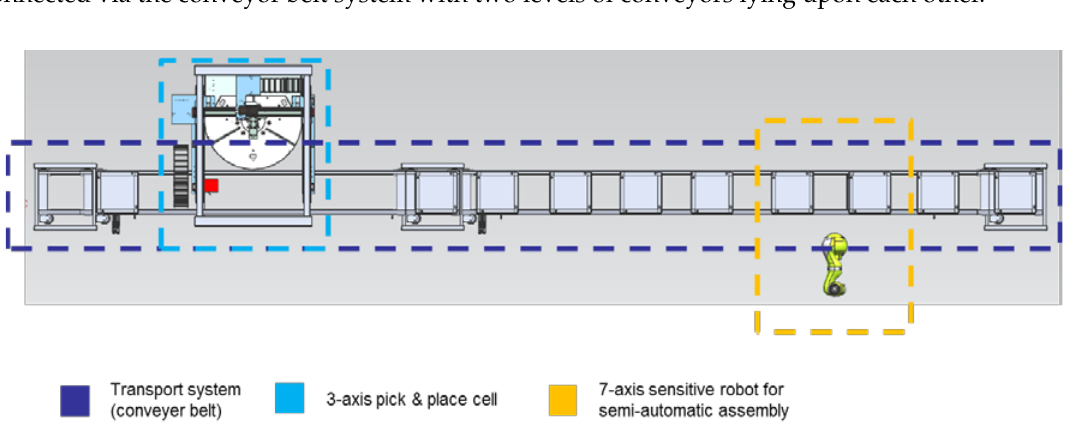
Figure 8. CAD model, behavior model, schematic diagram, and signal list of a module of the construction kit (conveyor belt lift).